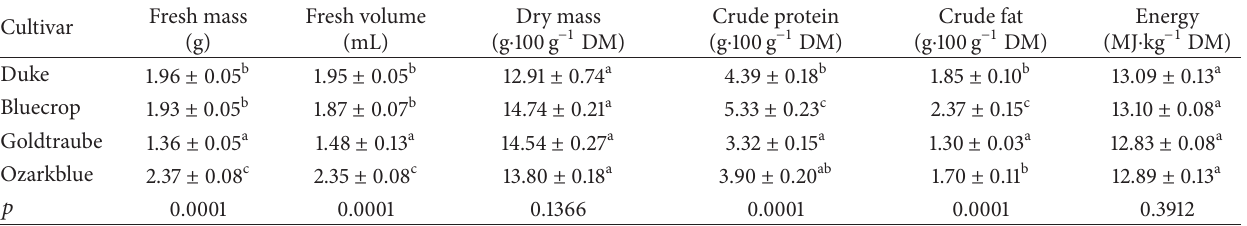
Table 2: Means of three years and two altitudes for fresh mass, volume, dry mass, crude protein, crude fat, and energy in four blueberry cultivars. Means ( 𝑛 = 36 ) ± SEM (standard error of the mean). Cultivar